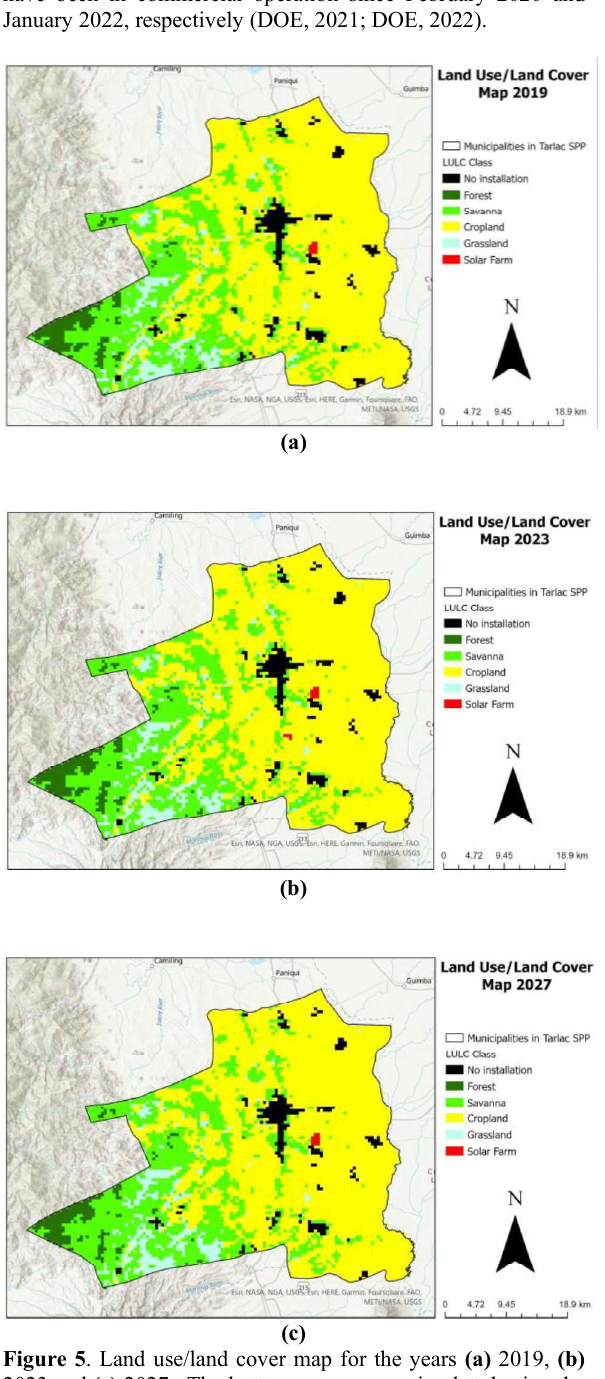
Figure 5 . Land use/land cover map for the years (a) 2019, (b) 2023 and (c) 2027. The last two maps were simulated using the Cellular Automata in MOLUSCE plugin.